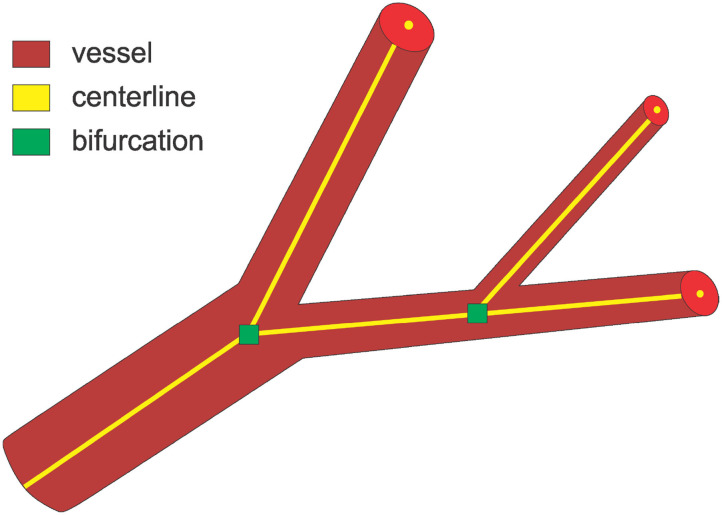
An overview of the three main tasks tackled in this paper. For bifurcations, we predict a neighborhood cube around the indicated point.